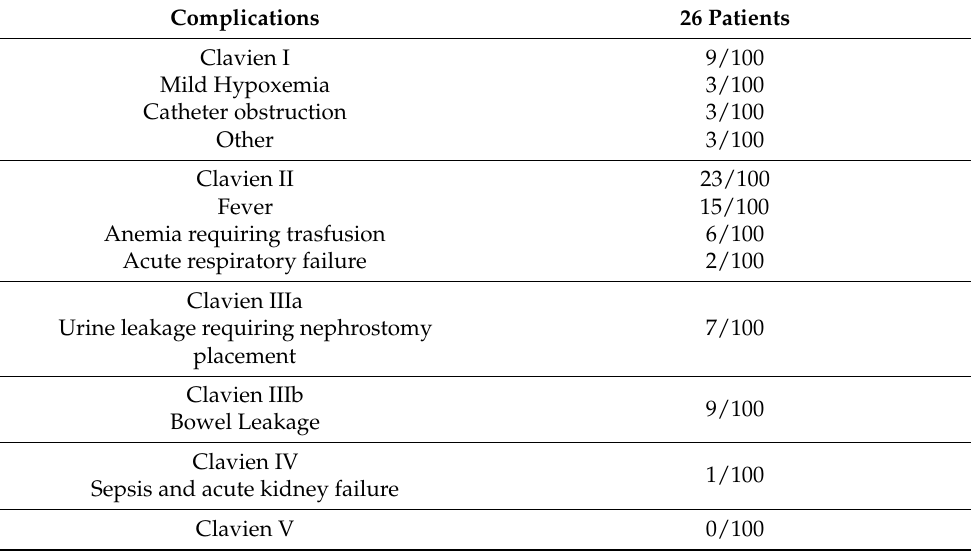
Table 2. Complications according to Clavien classification system.